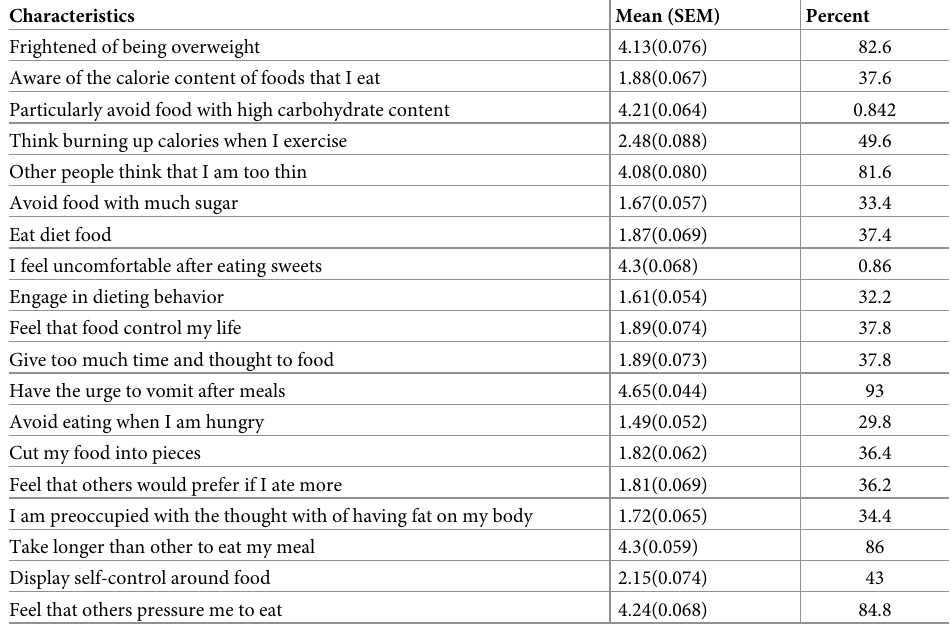
Table 3. Mean perception of dietary and related condition of the adolescent in Addis Ababa city, Ethiopia. Characteristics